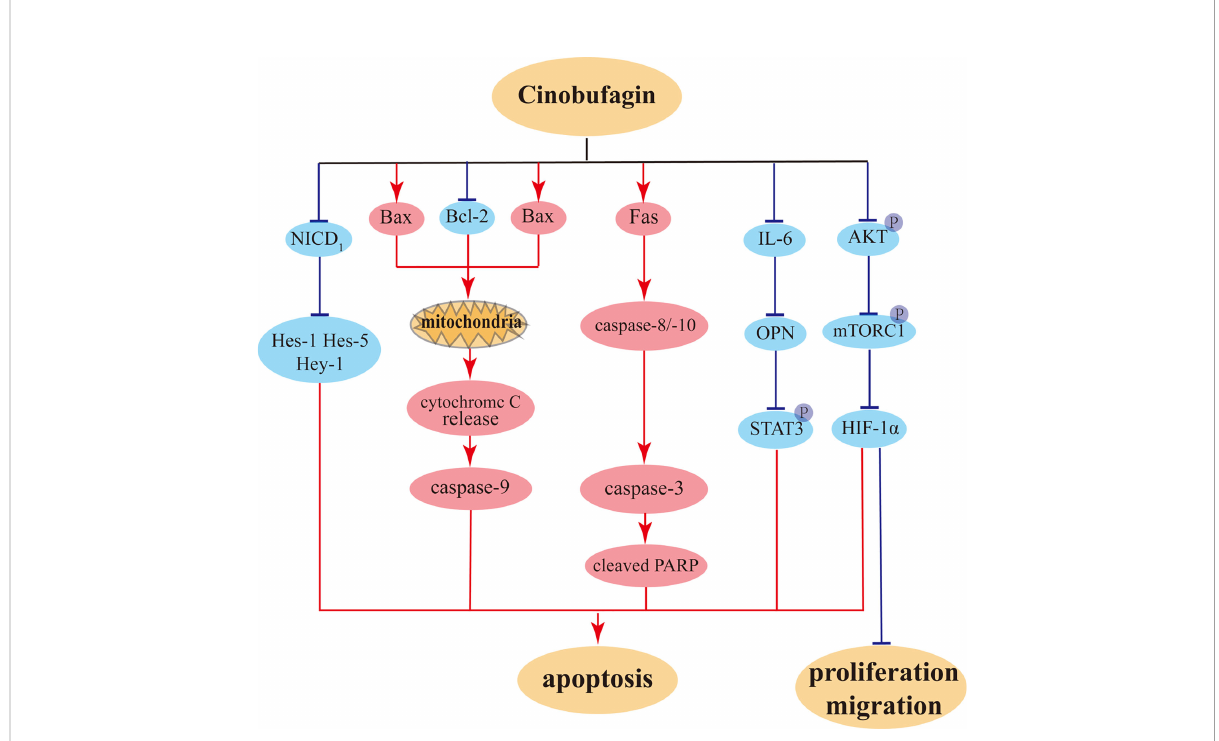
FIGURE 6 The potential anti-proliferation, anti-migration, and pro-apoptosis pathways of cinobufagin on tumor